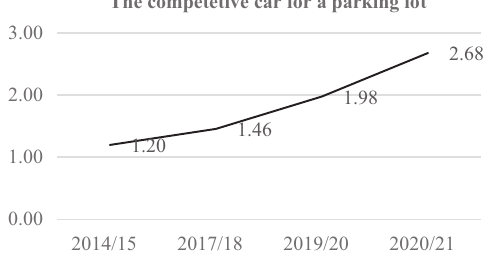
Fig. 1. Parking lot requirement based on academic